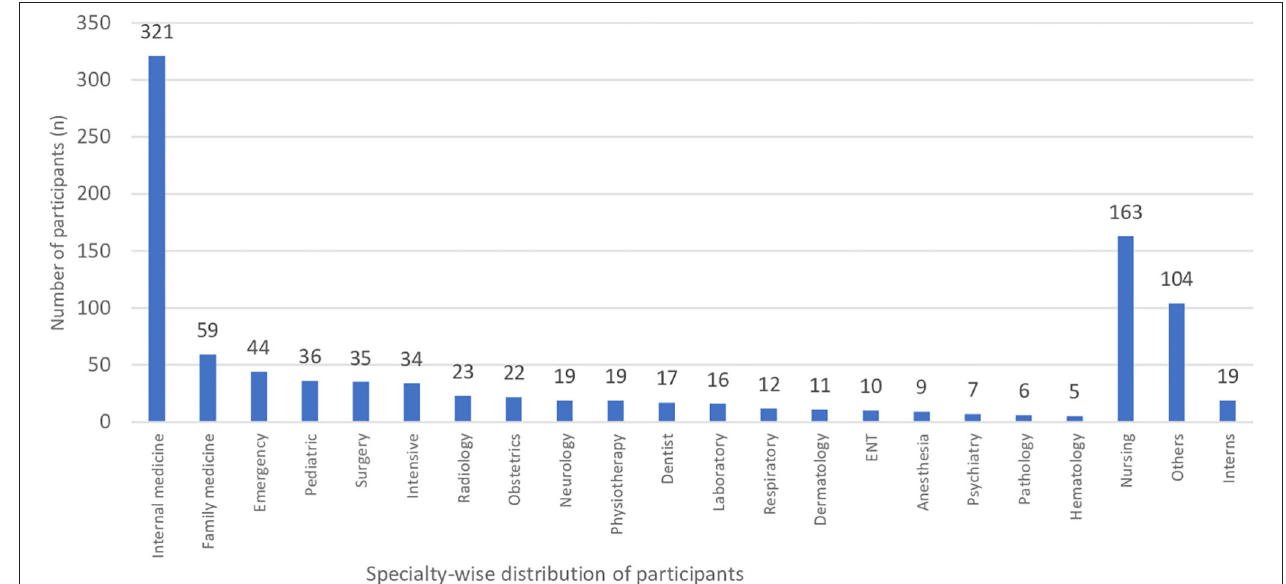
FIGURE 1 | Specialty-wise distribution participants.